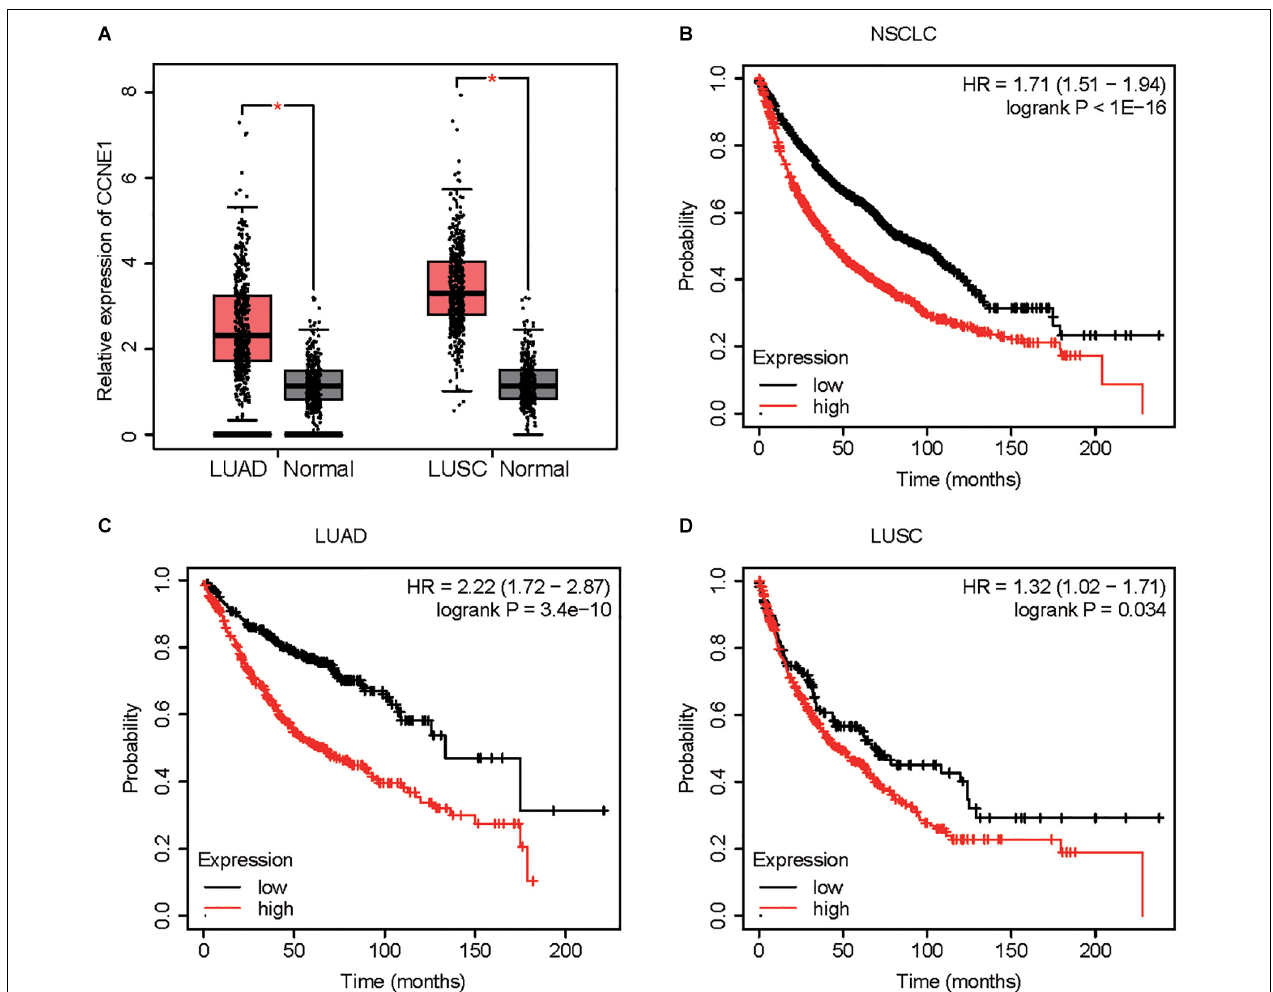
FIGURE 7 | CCNE1 is up-regulated in NSCLC. (A) GEPIA database indicated CCNE1 was up-regulated in NSCLC samples when compared with normal tissues. (B–D) Kaplan–Meier analysis demonstrated that higher expression levels of CCNE1 correlated with longer survival time in patients with NSCLC, LUAD, and LUSC by using the Kaplan–Meier plotter database (* P < 0.05). NSCLC, non-small cell lung cancer; GEPIA, Gene Expression Profiling Interactive Analysis; LUAD, lung adenocarcinoma; LUSC, lung squamous cell